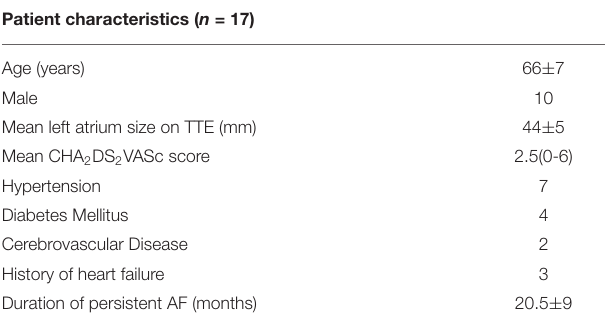
TABLE 1 | Patient characteristics of invasive clinical